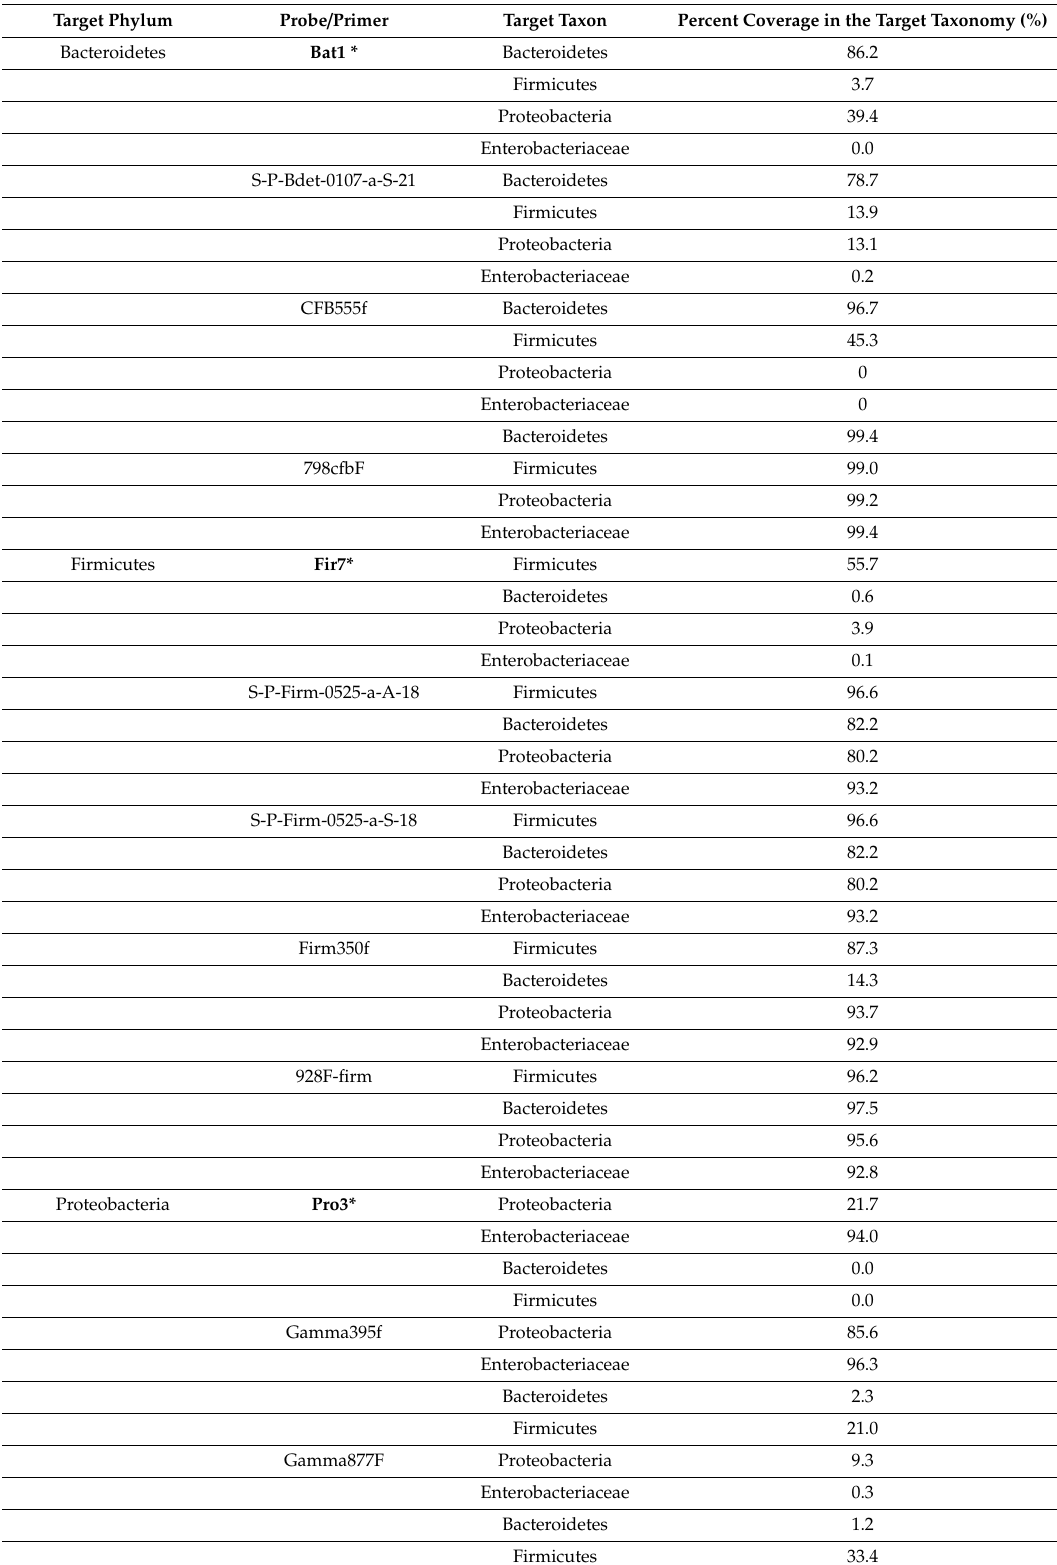
Table 6. Comparisonofthespecificitybetweenprobesfromthecurrentstudywiththosepreviouslyreported. Target